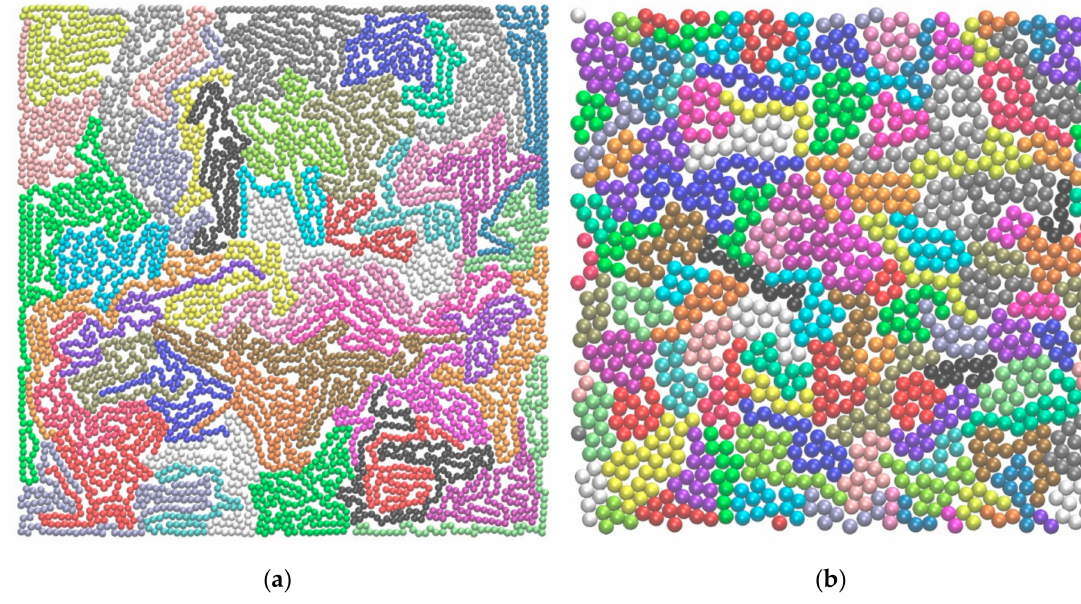
Figure A2. Snapshots of equilibrated packings of linear, hard-sphere chains used as initial configurations for successive simulations with the hard sphere or square well potential. ( a ) 48 chains of N av = 100 at ϕ = 0.05 under confinement in all dimensions; ( b ) 100 chains of N av = 12 at ϕ = 0.48 with periodic boundary conditions in the long dimensions and confinement in the short one. Spheres are colored according to the parent chain. Each figure panel is also available as stand-alone image in 3-D, interactive format in the Supplementary